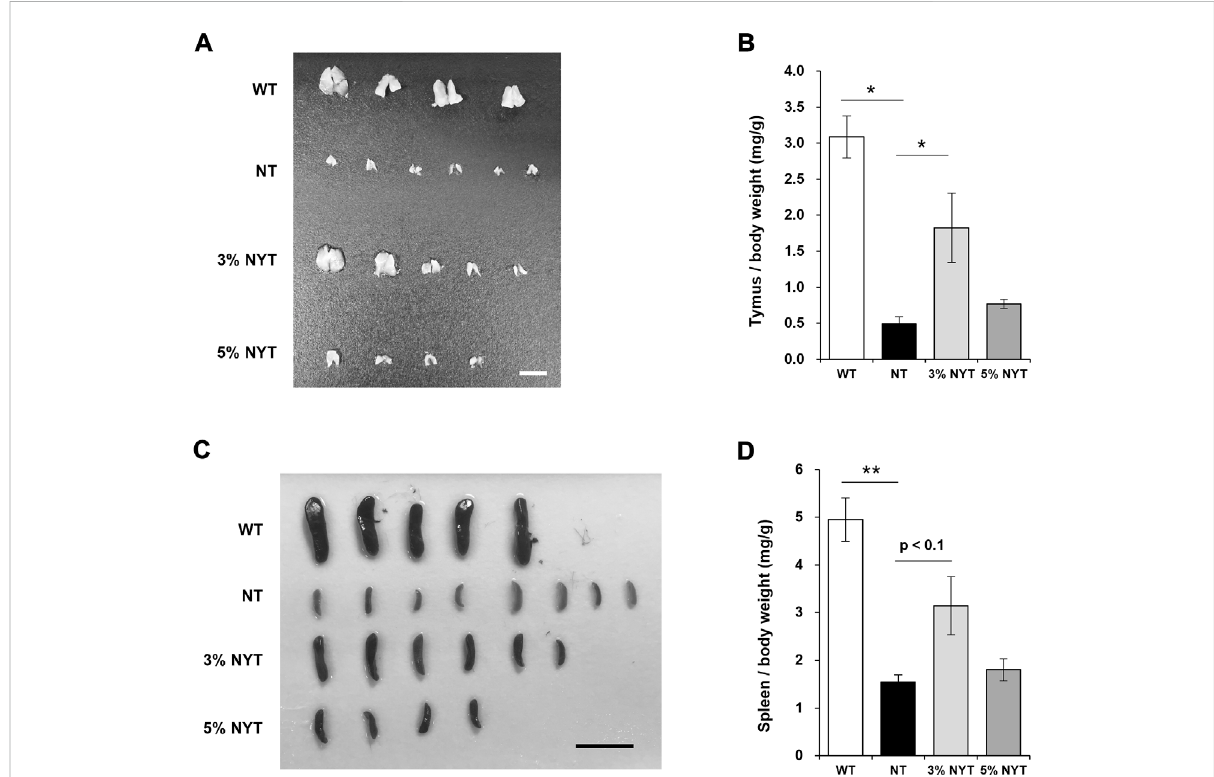
FIGURE 3 Effect of NYT on age-related splenic and thymic atrophy. The dissected Thymus (A) and Spleen (C) tissue images on 59 days old and its wet weights (B , D) areshown,scalebarindicated5 mm (A) ,15 mm (C) .Thewetweightsoflungtissueareshown (D) .DataareindicatedasmeanandSEM values. Signi fi cant differences are presented on histograms: [* p < 0.05, ** p < 0.01, Steel test (A) , WT ( n = 4), NT (6), 3%NYT (5), 5%NYT (4); Dunnett ’ s contrast (B) , WT ( n = 5), NT (8), 3%NYT (6), 5%NYT